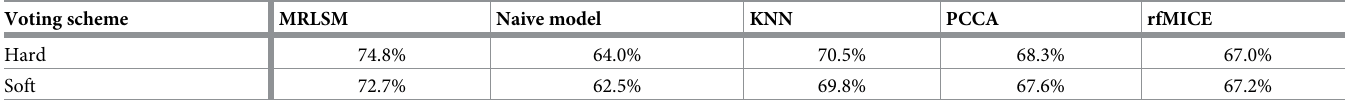
Table 3. Accuracies for group classification under hard and soft voting schemes using different models.